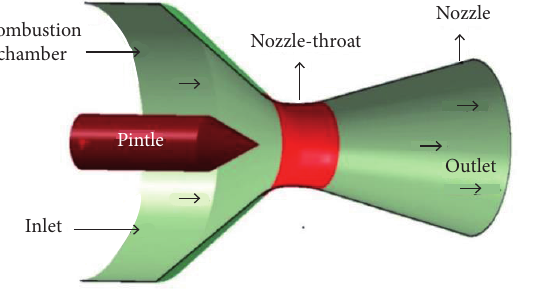
Figure 1. Schematic of pintle